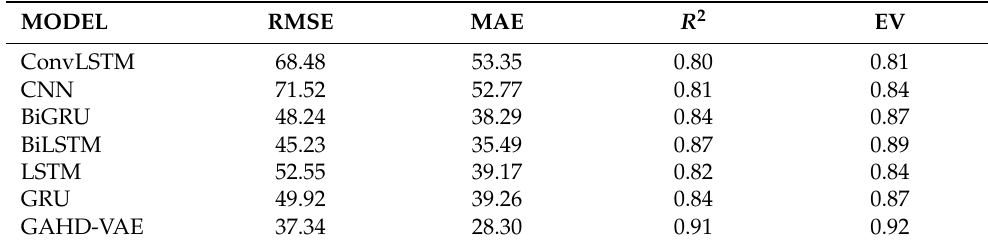
Table 9. Averaged measurements of effectiveness per model for daily forecasting of pedestrian and bicycle traffic